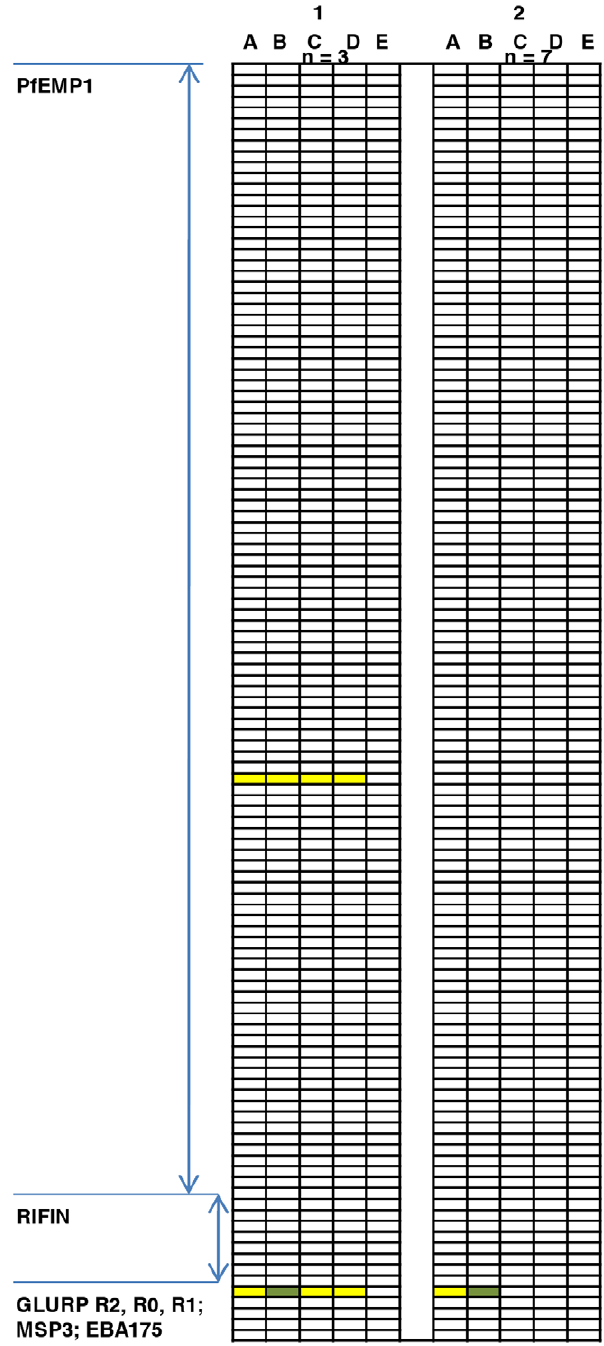
Figure 6. Acquisition of IgG Abs to 104 PfEMP1 domains, eight RIFINs, and GLURP, MSP3, and EBA-175 antigens in two immunized volunteers. The two volunteers, 1 and 2, were selected to represent volunteers with acquisition of antibodies to PfEMP1 and merozoite antigens ( n =3) and volunteers with acquisition of antibodies to the merozoite antigens only ( n =7). The letters A, B, C, D and E correspond to 32, 60, 116, 151 and 256 days after first immunization. Parasite challenges were at day 118 [37]. The results are expressed as median fluorescent intensity (MFI): Red . 2000 MFI; Green . 1000 MFI; Yellow . 500 MFI (cut-off value).